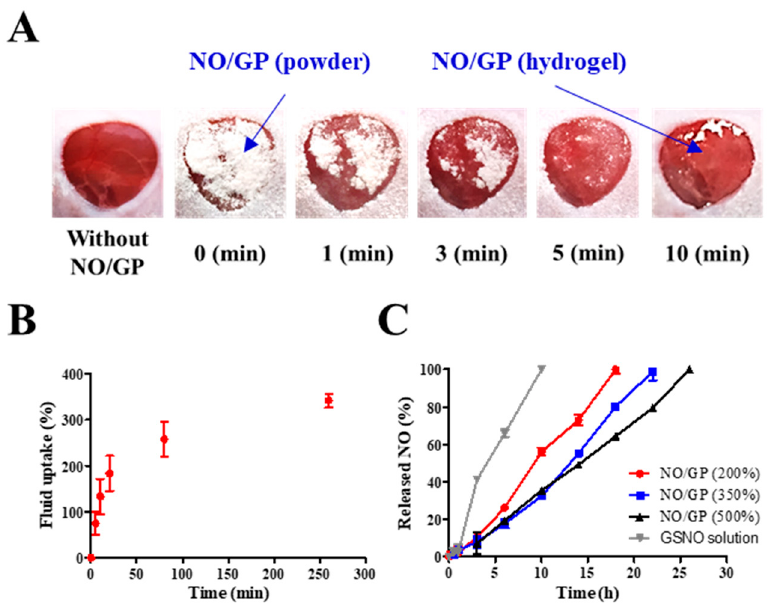
Figure 4. Behavior of NO/GP following exposure to wound fluid. Morphological changes in NO/GP applied to the mouse full-thickness wound model ( A ). Fluid uptake profile of NO/GP (amount of absorbed SWF is presented as the percent per initial NO/GP powder weight) ( B ). NO release profiles of NO/GP under different swelling conditions and the GSNO solution at the equivalent concentration to 350% swollen NO/GP ( C ). Each point represents the mean ± standard deviation ( n = 3).